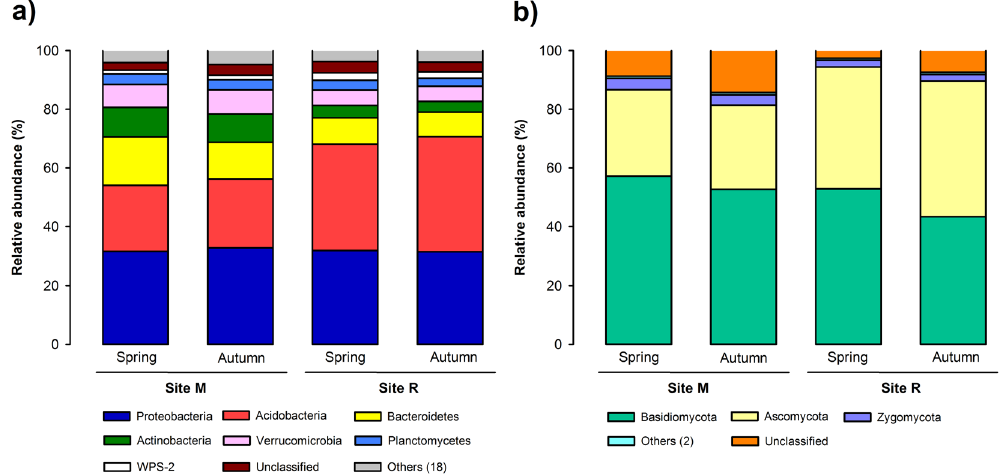
Figure 1. Relative abundance of the bacterial ( a ) and fungal ( b ) phyla found at the deciduous forest site M (545–570 m asl) and the coniferous forest site R (1,724–1,737 m) in spring and autumn. Site M Site R